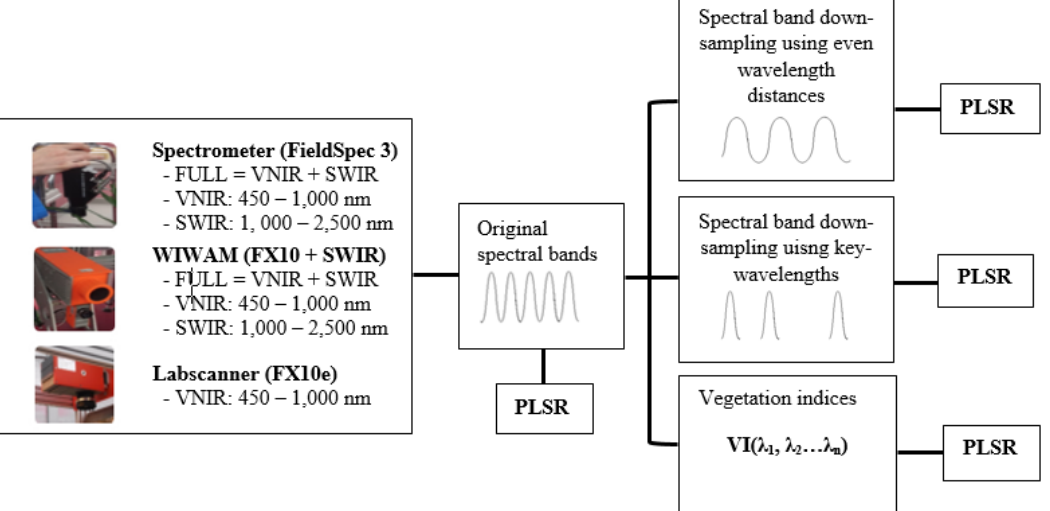
Figure 2. Data transformation and PLSR. First, the pre ‐ processed data from different sensors was separated into the different ranges of visible and near ‐ infrared (VNIR), short ‐ wave infrared wavelengths (SWIR) and VNIR + SWIR (FULL) for PLSR. Then in each range, the data was re ‐ sampled to different spectral bands or transformed into different VIs for PLSR.